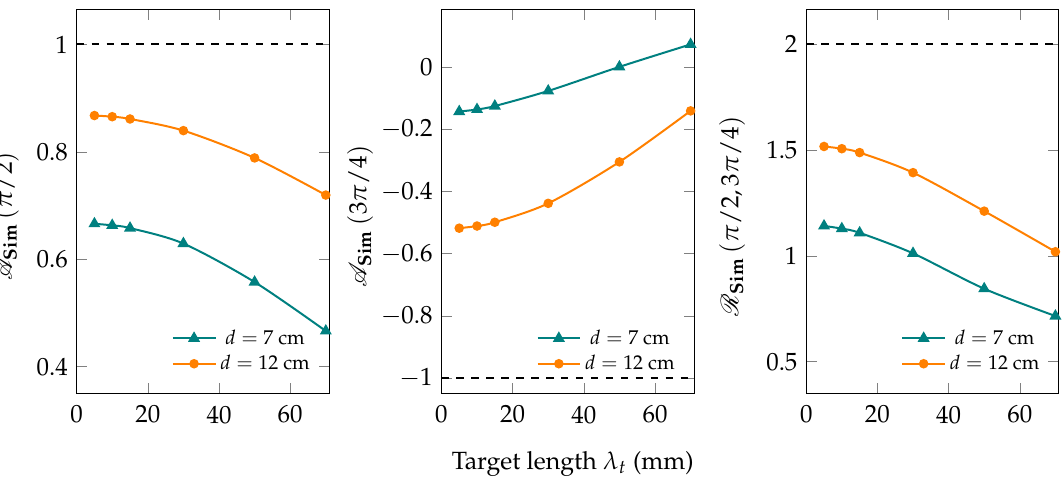
Figure 8. The same as Figure 5 for the quadrupole transition with a spin sequence of 0 → 2 → 0.